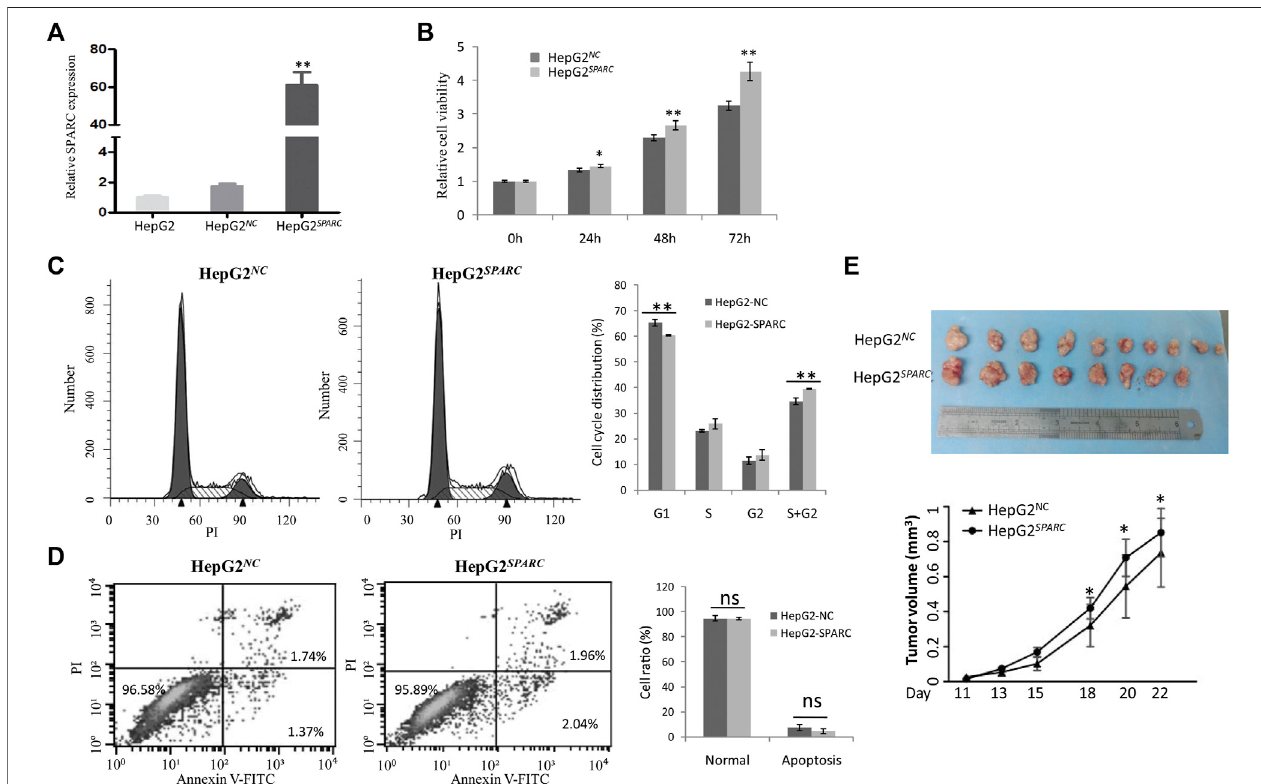
FIGURE 3 | Endogenous SPARC overexpression promote liver cancer cells proliferation and tumor growth. (A) qRT-PCR showed the higher SPARC expression level in HepG2 SPARC . (B) SPARC overexpression promotes liver cancer cell proliferation. (C) FCM showed the effects of SPARC overexpression on cell cycle. (D) FCM showed the effects of SPARC overexpression on cell apoptosis. (E) SPARC overexpression promotes tumor growth in vivo